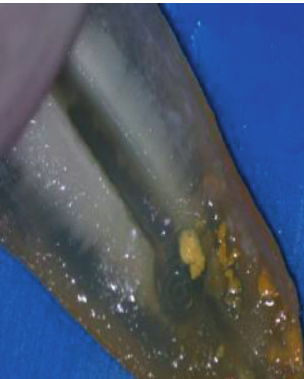
Figure 2: Score 1. Less than half of the cavity is filled with CH remnants.